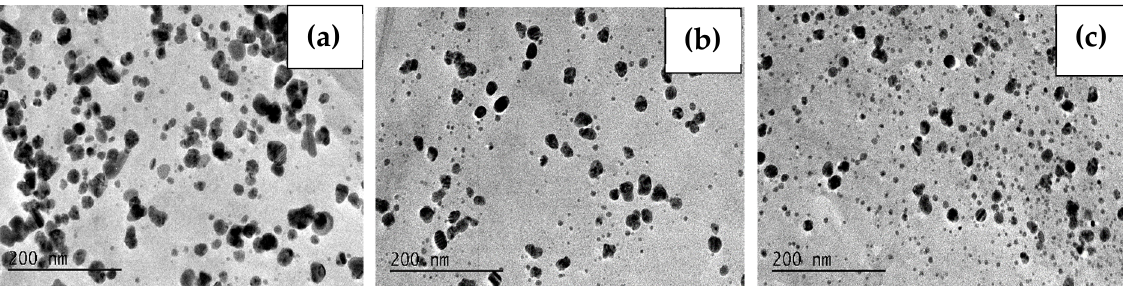
Figure 3. TEM images of the samples ( a ) Ag-72-20 ° C, ( b ) Ag-72-30 ° C and ( c ) Ag-72-40 ° C.